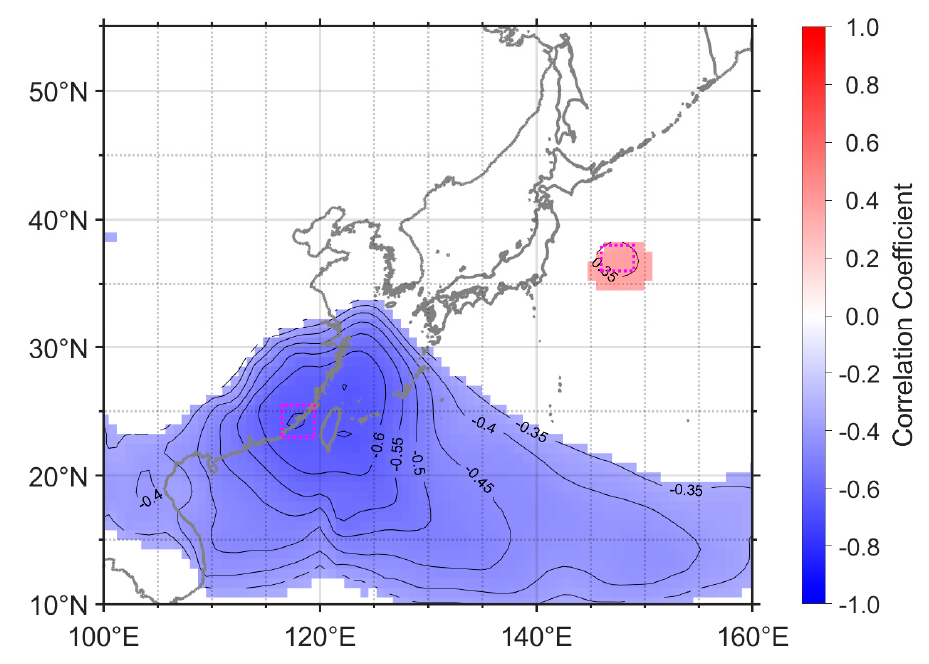
Figure 9. Correlation map of the NEAMS August sea-level with the mean sea-level atmospheric pressure from 1993 to 2018. The contour interval is 0.05 and confidence levels less than 90% were eliminated. Positive correlation means that high NEAMS sea-level occurs with high atmospheric pressure and negative correlation means that high NEAMS sea-level occurs with low atmospheric pressure. The areas showing the maximum (Kuroshio Extension (KE)) and minimum (west of Taiwan (WT)) correlation coe ffi cients are marked with magenta dotted boxes to make the index, August NEAMS sea-level index